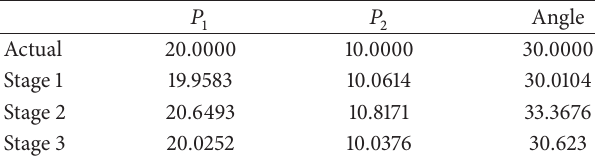
Table 4: Identified in situ stress and angle in different